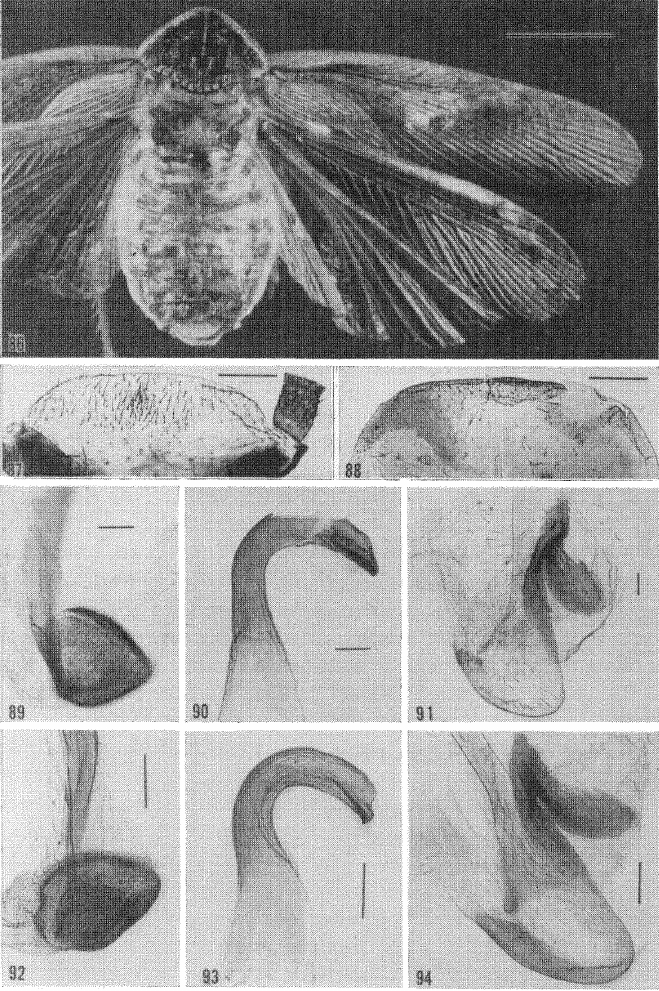
Figures 86-94. Calolampra siynatura. 86-91. (61 BMNH), holotype, St. Helena. 86. Adult. 87-88. Supra-anal plate and hypandrium. 89-91. Genitalia (R2 in figure 90, is damaged). 92-94. (67 MCZ). Genitalia of holotype of Calolampra aliena, Haiti. Scale.: Fig. 86 mm; Figs. 87- 88 0.5 mm; Figs. 89-91 0.1 mm; Figs. 92-94 0.2